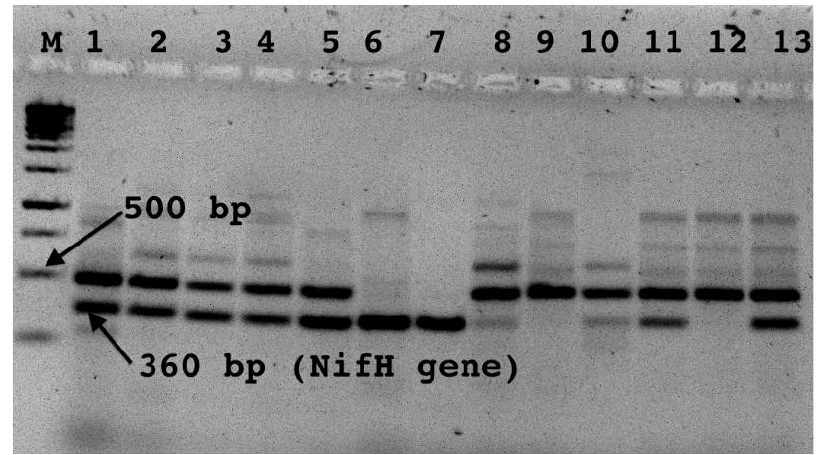
Figure 5. Result for presence nifH gene. Key : M: Marker, 1: NF0m15, 2: NF2.9m15, 3: NF2.9m18, 4: NF2.9m12, 5: NF10m9, 6: NF10m6, 7: NF14m10, 8: NF14m10.4, 9: NFM1.4, 10: NFM6.4, 11: NF7.4, 12: NFM18, 13: NFM19.